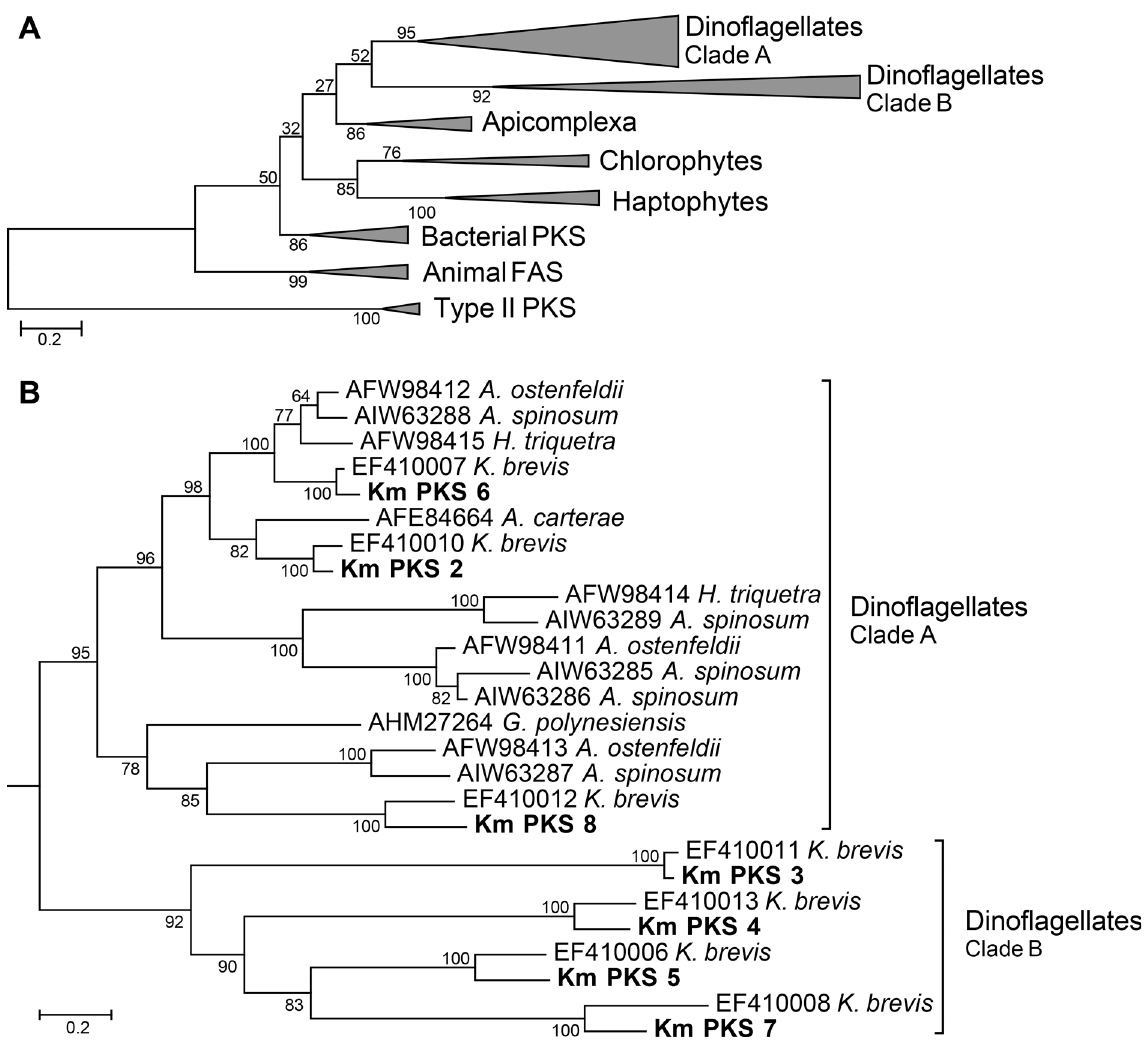
Fig 2. Phylogenetic analysis of the KS domains in type-I and type-II PKS and fatty acid synthase (FAS). (A) KS domains of 59 taxa were analyzed using the maximum likelihood (ML) method. (B) Focused ML-tree of PKS_KS domains of dinoflagellate. Bootstrap values (%) from 100 samples are shown at the nodes in each tree. ML distance scale bars are shown under the trees. Bars with descriptions on the right show clades of each type of PKS